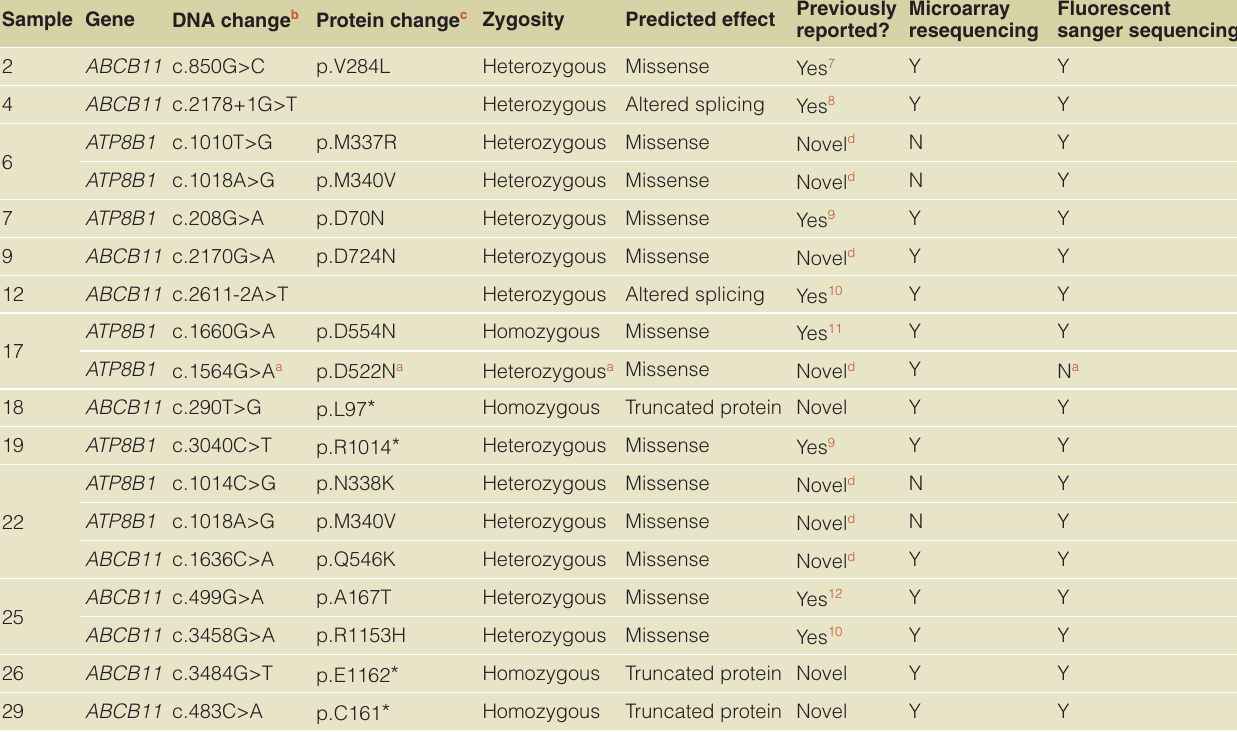
Table 1. The sequence variants identified in this study. Sample Gene DNA change b Protein change c Zygosity Predicted effect